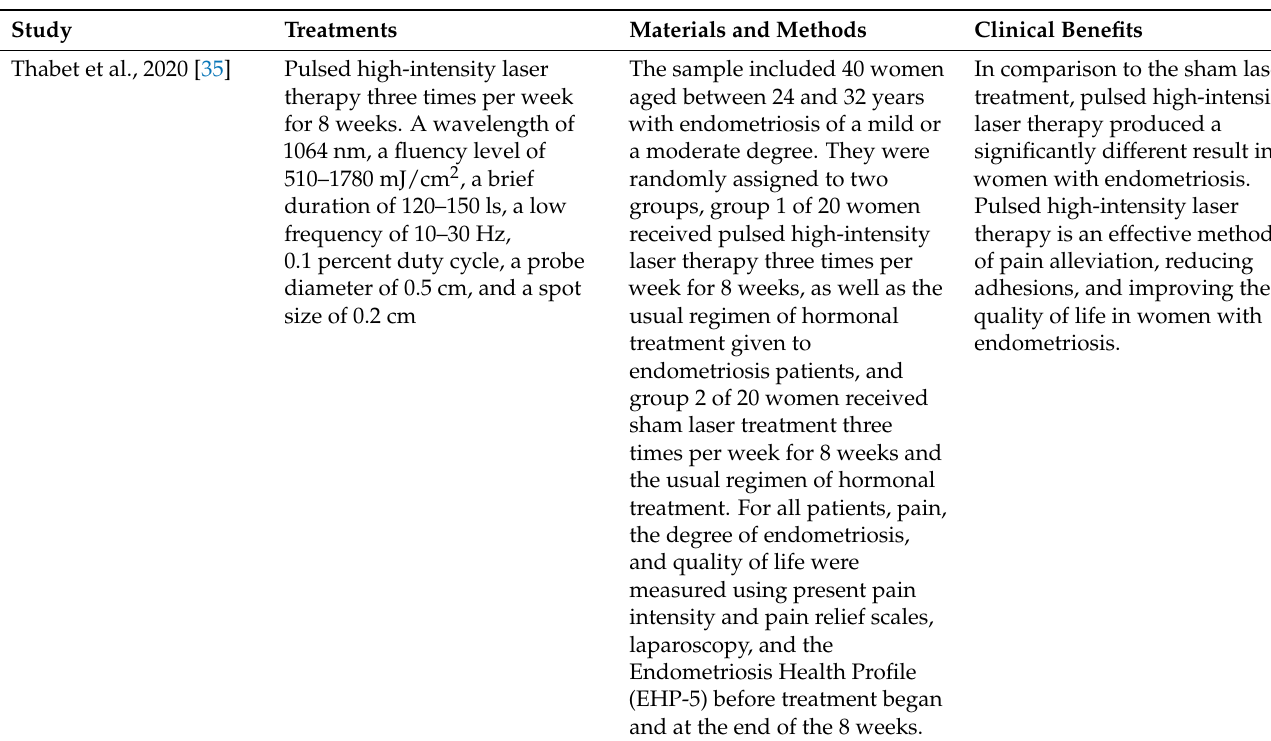
Table 1. Form of physiotherapy applied, e.g., laser therapy, TENS, electromagnetic